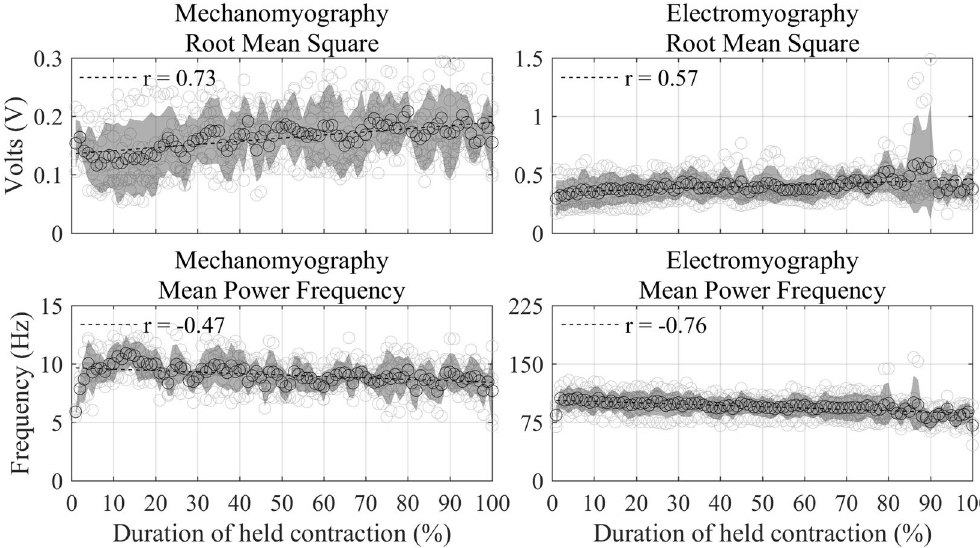
Figure 3. Grouped participant data showing significant ( P < 0.01) changes in RMS (top row) and MPF (bottom row) for both MMG (left column) and EMG (right column) during the sustained exerting task. Standard deviation is plotted as a shaded envelope, as well as linear lines of best fit and the calculated Pearson’s correlation